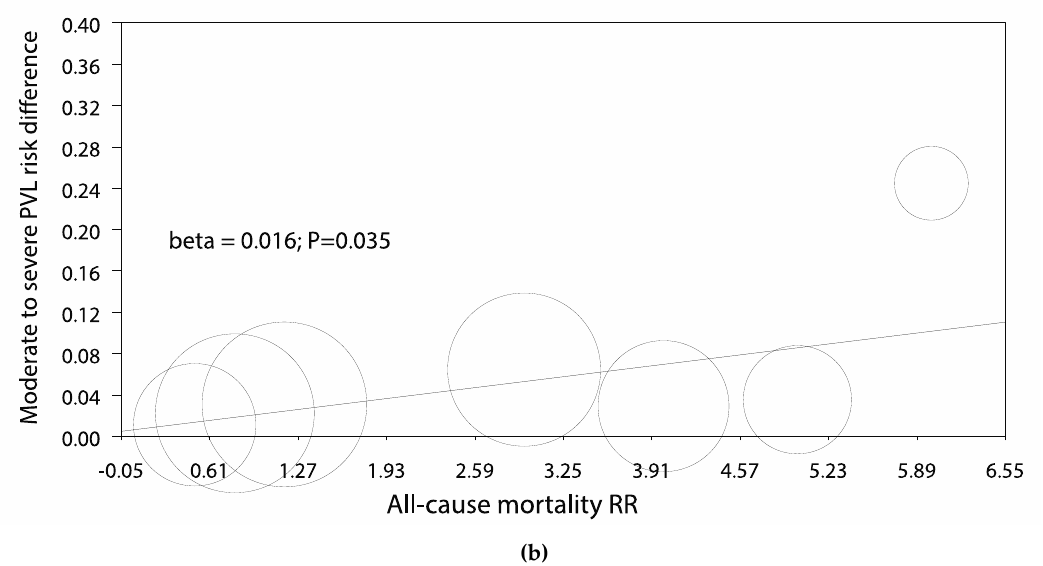
Figure 5. Individual and summary risk ratios with corresponding 95% confidence intervals for the comparison of ACURATE neo vs SAPIEN 3 in the analysis of ( a ) 30-day all-cause mortality; ( b and c ) meta regression analyses .